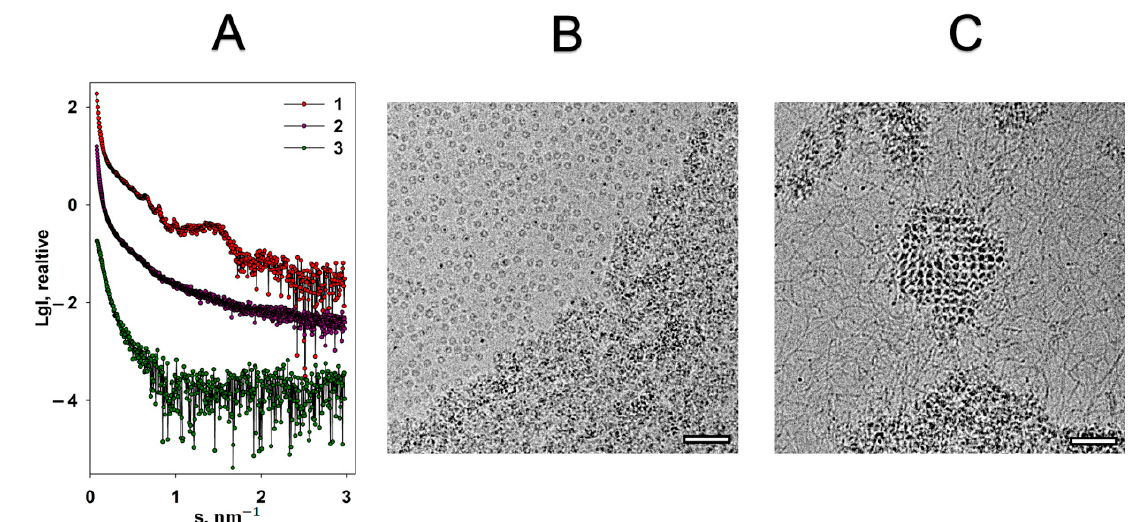
Figure 3. The effect of FeSO 4 on the Dps-DNA co-crystals. ( A ) Experimental SAXS curves from: 1—Dps-DNA co-crystals, 2—Dps-DNA co-crystals in the presence of 20 mM FeSO 4 , 3—Dps-DNA co-crystals with 20 mM FeSO 4 and EDTA. Cryo-EM data of Dps-DNA co-crystals with FeSO 4 ( B ) and Dps-DNA co-crystals with FeSO 4 and EDTA ( C ). Bar length is 50 nm.